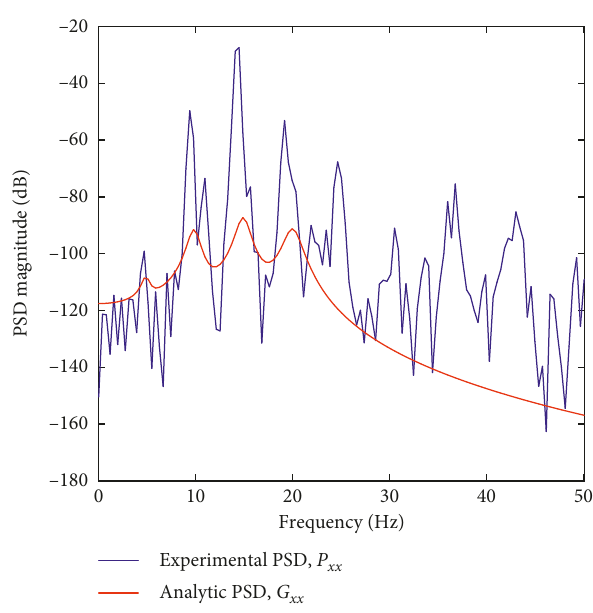
Figure 13: Comparison between analytical and experimental PSD